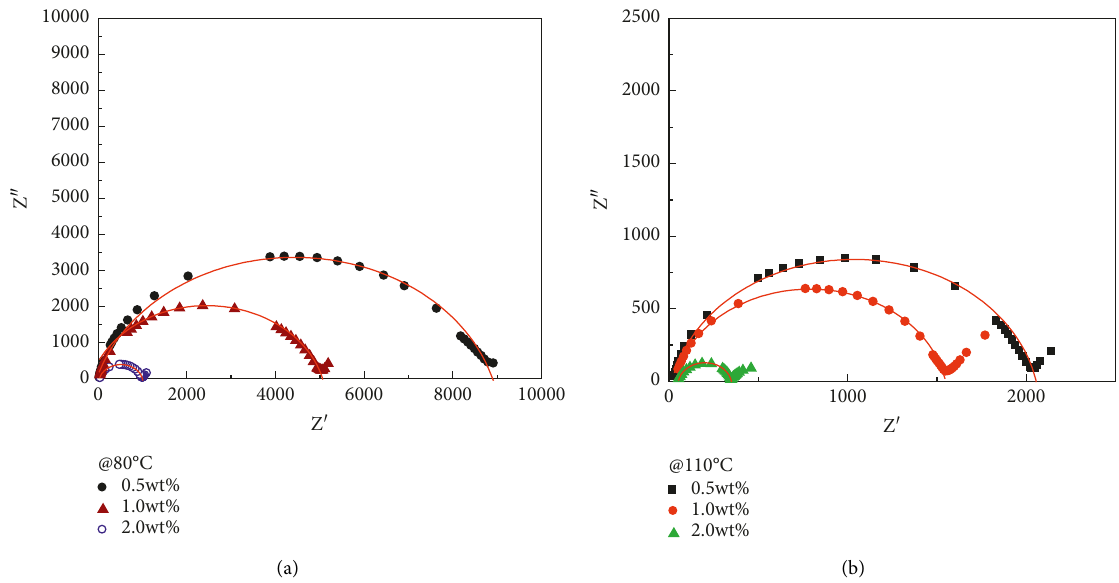
Figure 10: Complex plane plots (Z